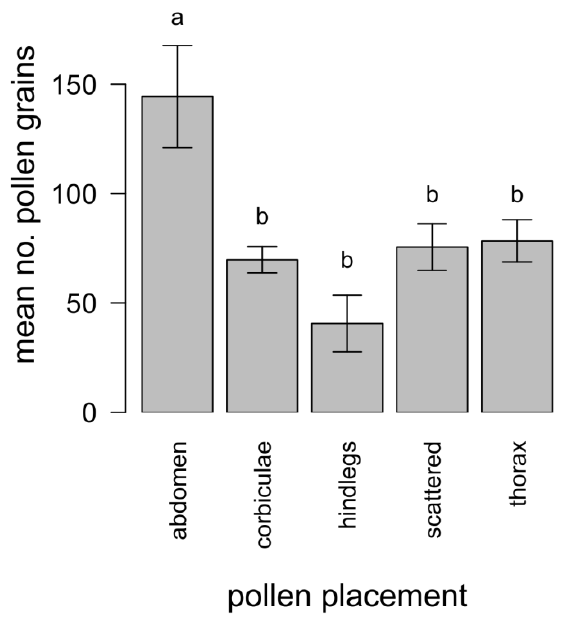
F IGURE 5. The mean (+/- standard error) number of pollen grains deposited by bees according to where pollen was predominantly placed on their bodies. N = 152 bees. Letters indicate significant differences (P < 0.05)